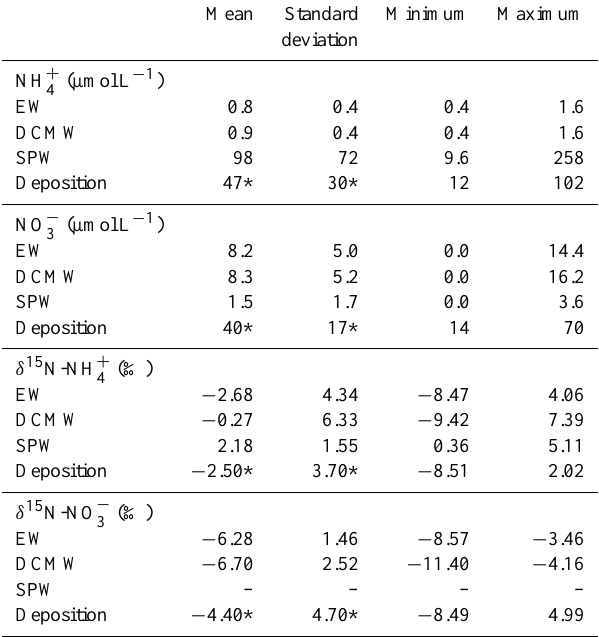
Table 3. Descriptive statistics of concentration and isotopic com- position of ammonium and nitrate in the lake compartments and deposition.